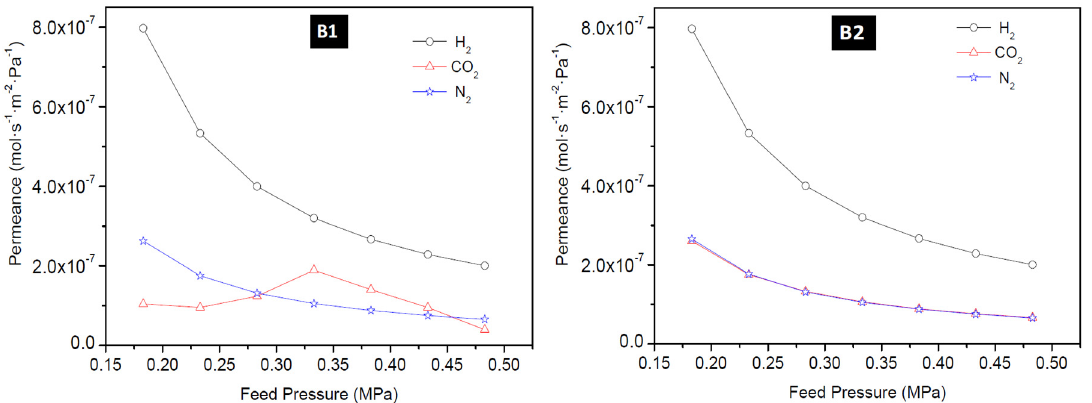
Figure 9. H 2 permeance, CO 2 permeance and N 2 permeance as a function of feed pressure at 25 °C for membrane M1 prepared using PPH (1-interruption) and M4 using PPH (2-interruptions).